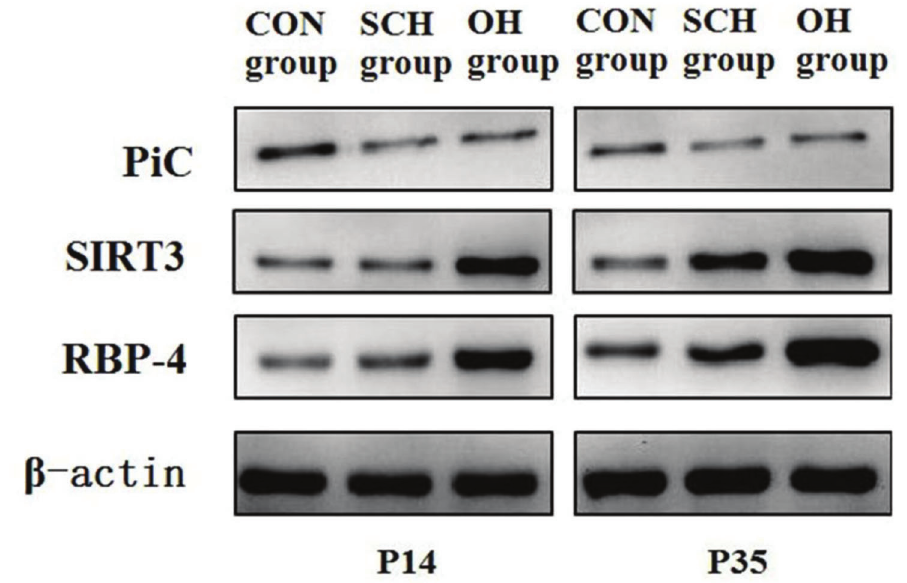
Figure 3 - Protein expression levels of RBP4, PiC, and SIRT3 in the different groups. Retinol-binding protein 4 (RBP4); Phosphoric acid carrier vector (PiC); Silent mating-type information regulation 3 homolog